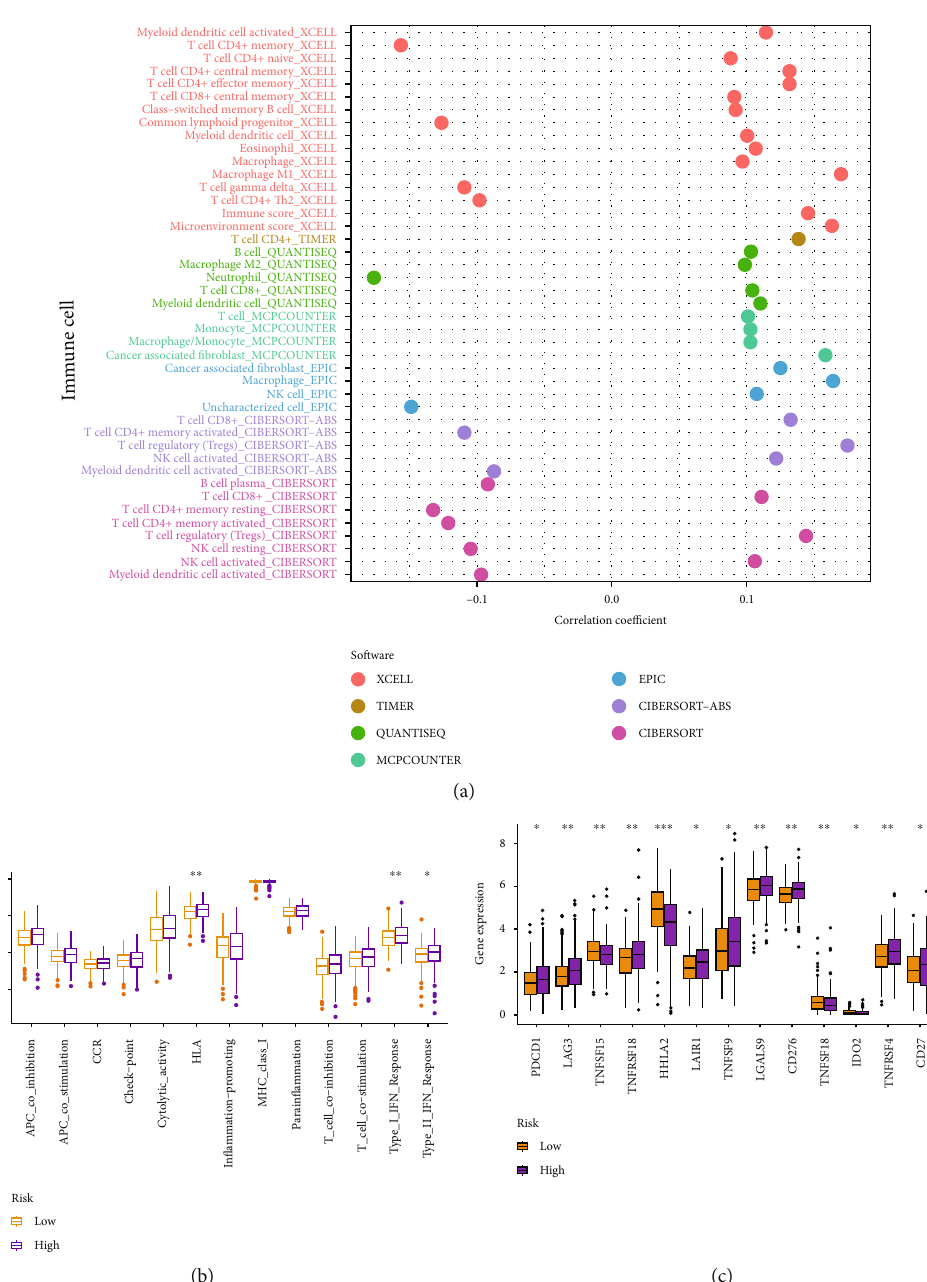
Figure 6: Immune analysis based on m 5 CRlncRNAs signature. (a) The immune cell bubble. (b) Immune functions scores between di ff erent groups. (c) Expression of immune checkpoint-related